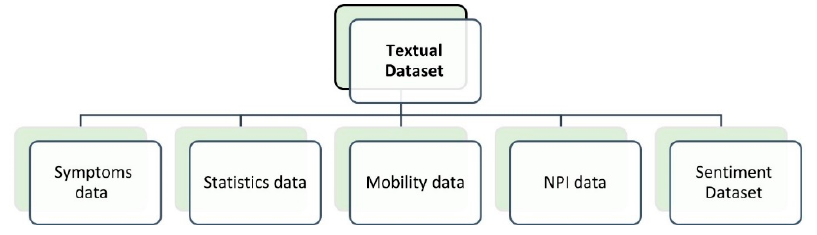
Figure 7. Types of textual